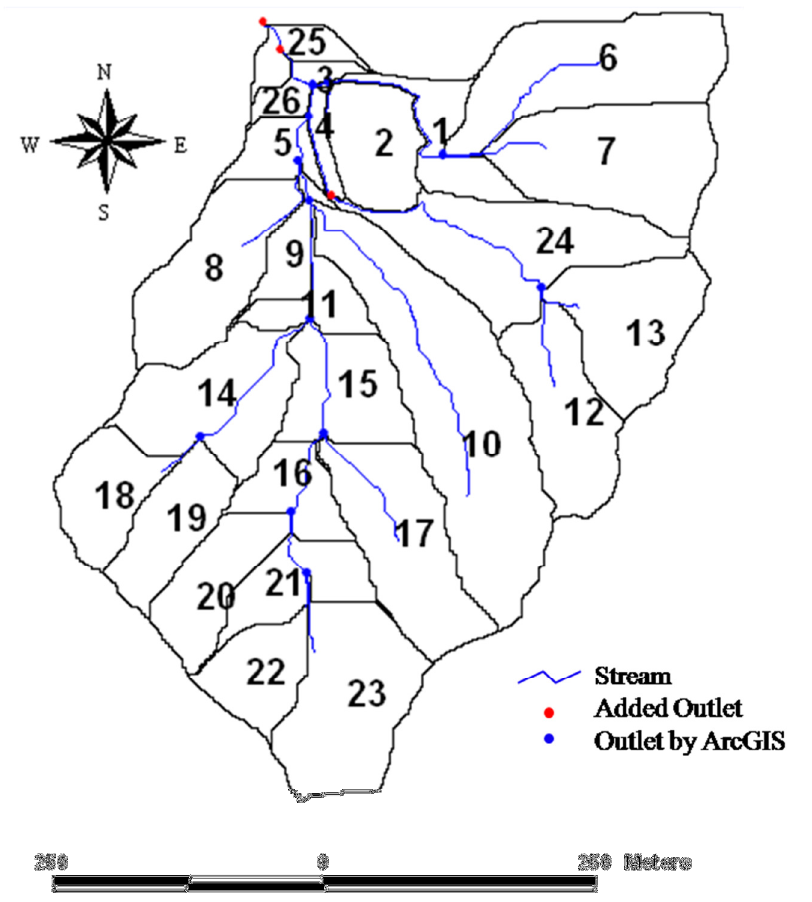
Figure 10. Subwatersheds Delineated for Simulation of VFS.